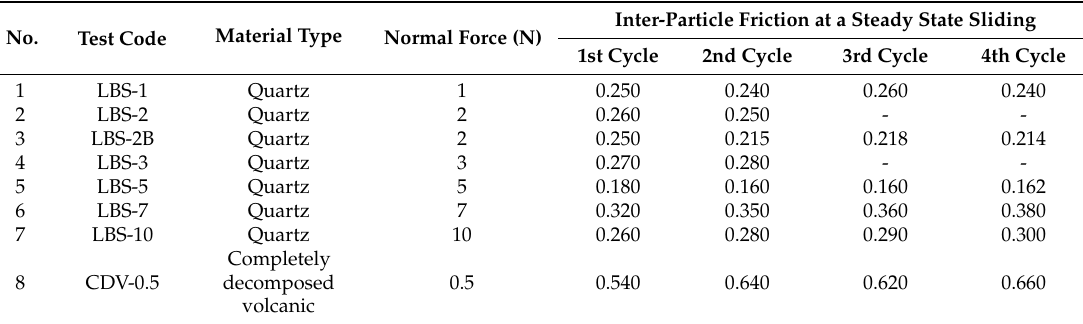
Table 1. Micro-mechanical sliding testing program and summary of